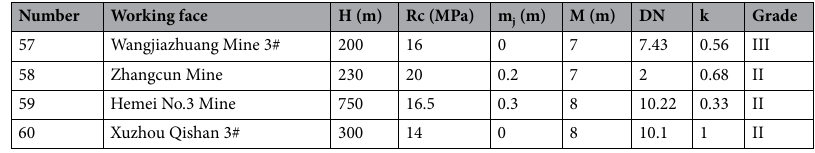
Table 2. Sample data. *Data comes from the database of published papers on